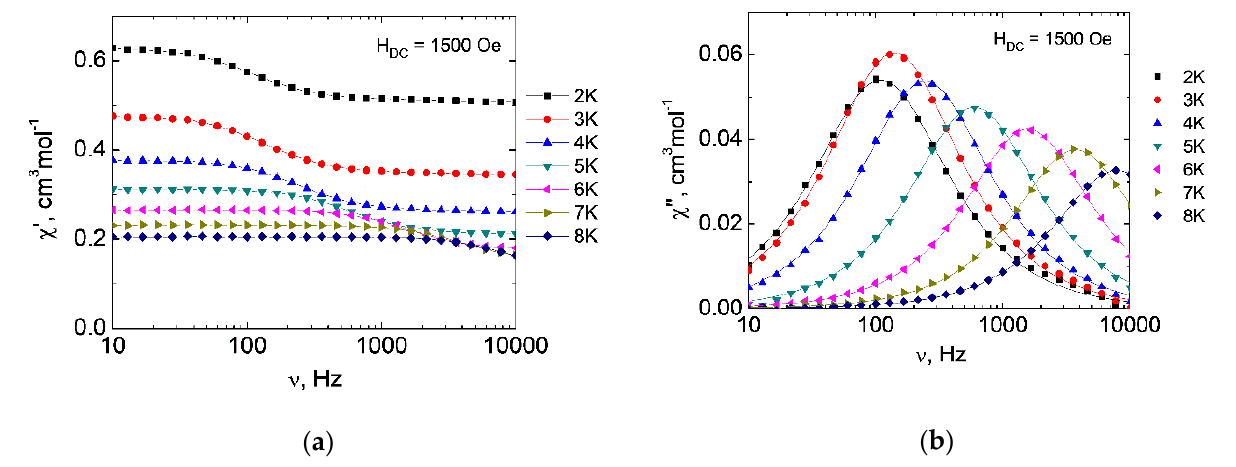
Figure 7. Frequency dependence of the real χ ’ ( a ) and imaginary χ ’’ ( b ) components of the ac magnetic susceptibility of 2 in the 1500 Oe field (lines are guides for the eyes ( χ ’), approximation using the generalized Debye model ( χ ’’)).